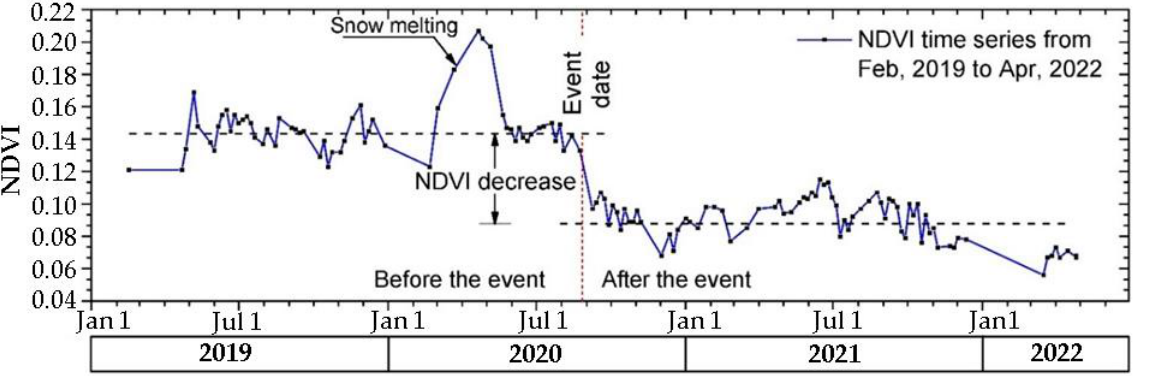
Figure 16. NDVI time series over the study area; the blue line indicates the raw NDVI from February 2019 to April 2022.